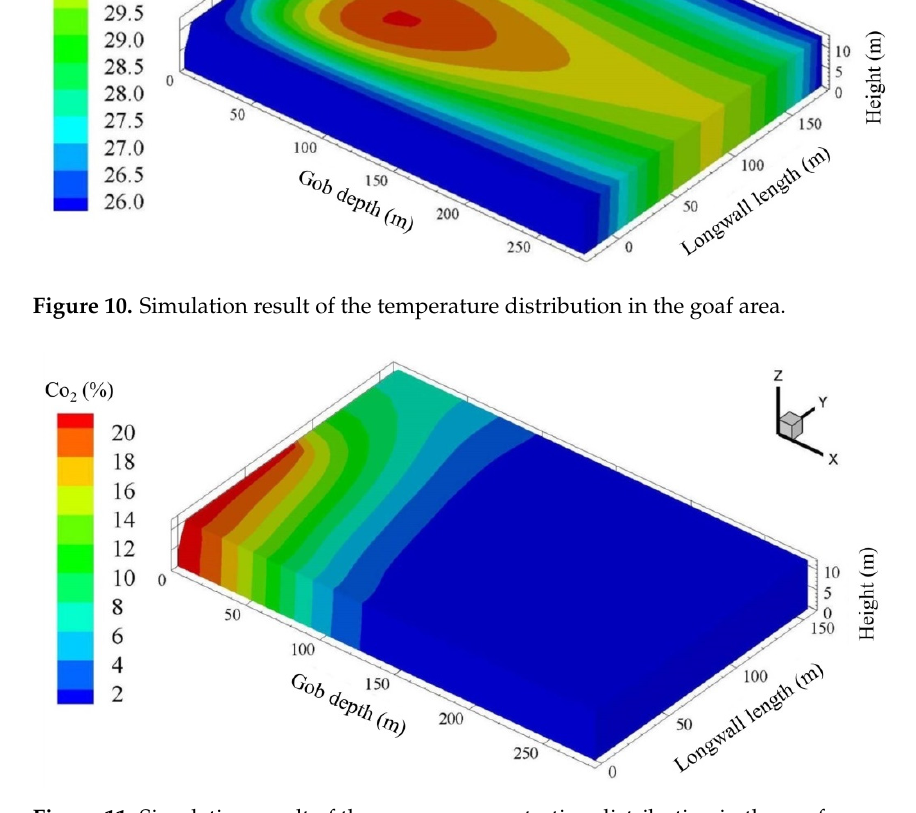
Figure 11. Simulation result of the oxygen concentration distribution in the goaf area. Table 3. Comparisons of the computation